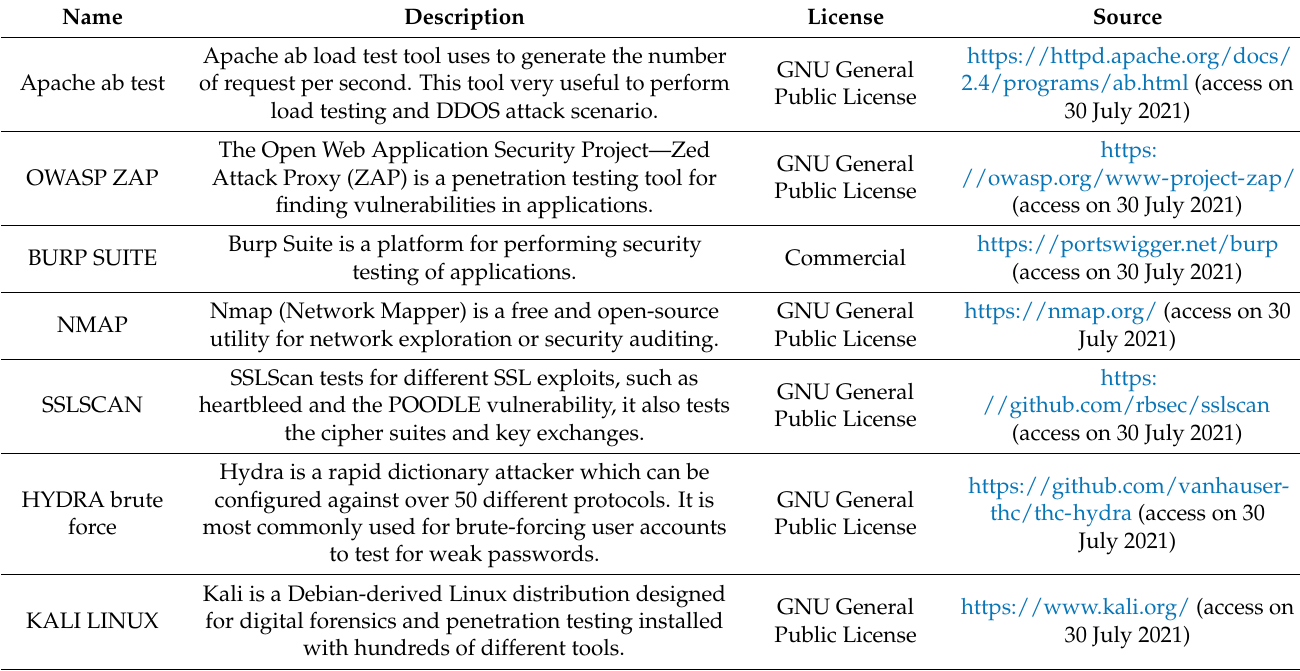
Table A3. List of tools for penetration